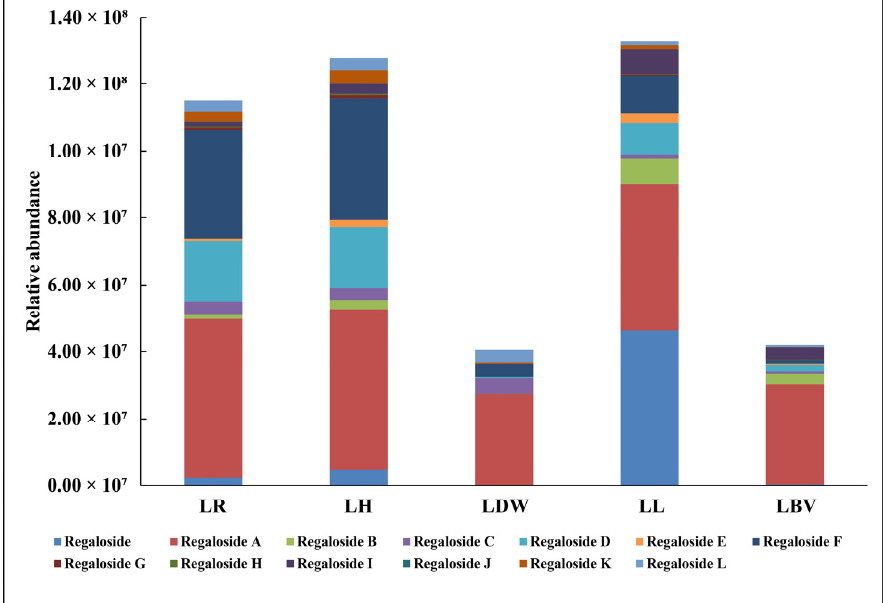
Figure 5. Distribution of phenylpropane glycerol glycosides (regalosides) in different lilies. LR: L. regale , LH: L. henryi , LL: L. lancifolium , LDW: L. davidii var. willmottiae , LBV: L. brownii var. viridulum .